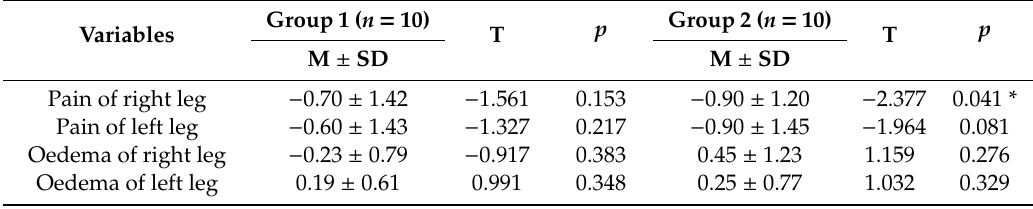
Table 3. Mean di ff erences in pain and oedema between stocking lengths before and after participants’ clinical training